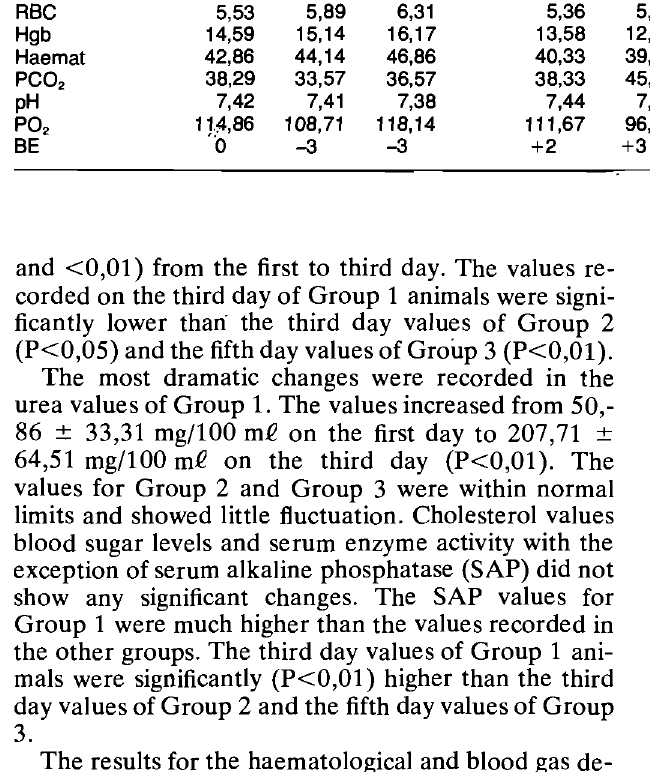
Table 2: HAEMATOLOGICAL AND BLOOD GAS DETERMINATIONS IN DIARRHOEIC BABOONS Group 1 Group 2